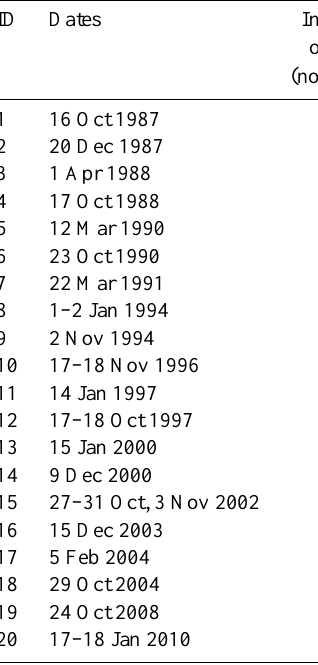
Table 1. Historic flash flood events in Wadi Watir and correspondence to rainfall events: 1 3 operational rain gauges in Wadi Watir until 2007, afterwards 9 more gauges were installed; 2 Range of satellite rainfall estimates by TRMM (product